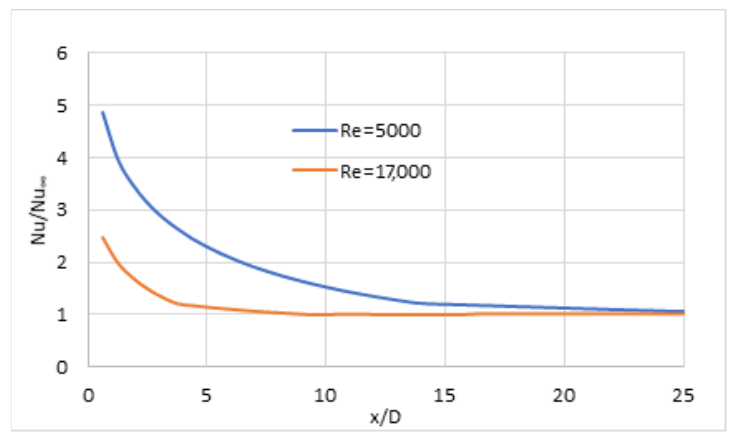
Figure 12. Local Nu number variation for 1.5 vol%